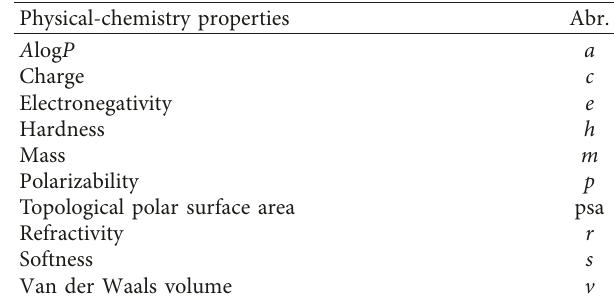
Table 2: Invariants used on the attributes calculations. Table 3: Physical-chemistry properties found in models LR1–4 and RF1.